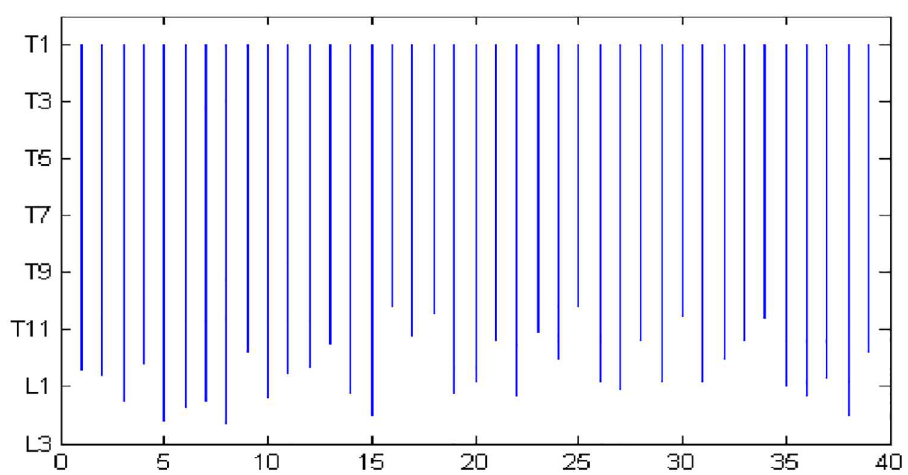
doi:10.1371/journal.pone.0168932.g004